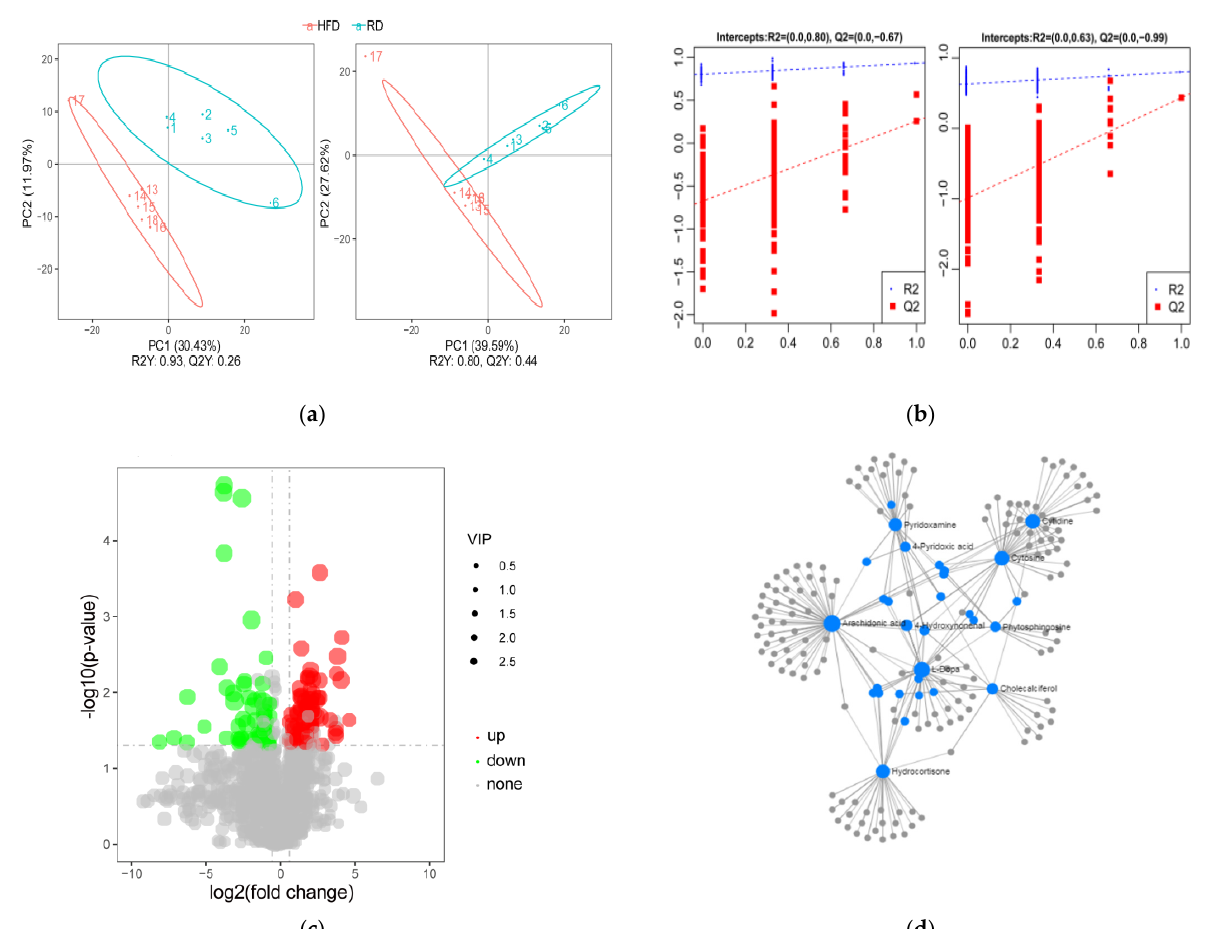
Figure 3. Identification and analysis of DE metabolites. ( a ) Partial least squares discriminant analysis (PLS-DA) of all metabolites in the samples of HFD ( n = 6) and RD ( n = 6) groups in the positive (left) and negative (right) ion modes. ( b ) The permutation test. ( c ) Volcano map of the DE metabolites screened between the HFD ( n = 6) and RD ( n = 6) groups and was built based on log2(fold change) and -log10( p -value). ( d ) The metabolite–metabolite interaction network was built by using the MetaboAnalyst database. High-fat diet: HFD and restricted diet: RD.